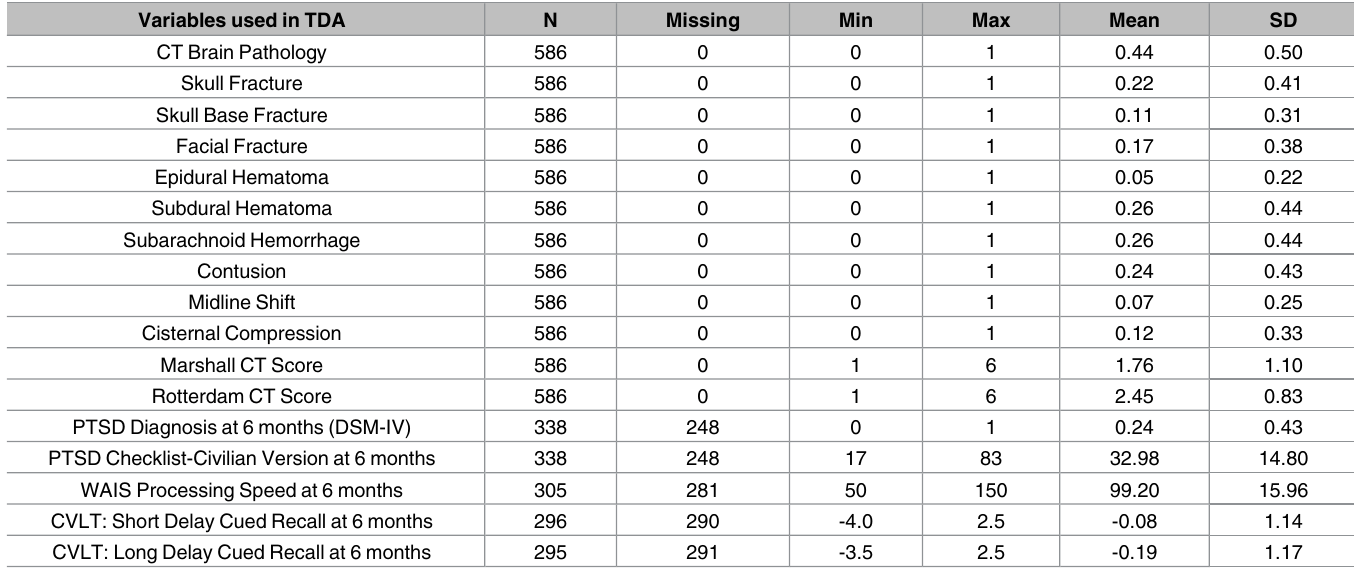
Table 2. Descriptivestatistics of CDE variables included in TDA to map TBI patients into a network topology based on TBI severity. Variables used in TDA